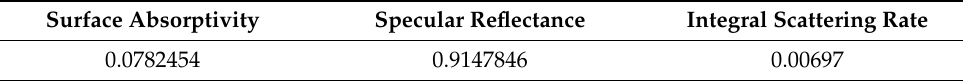
Table 5. Property settings of optical components.